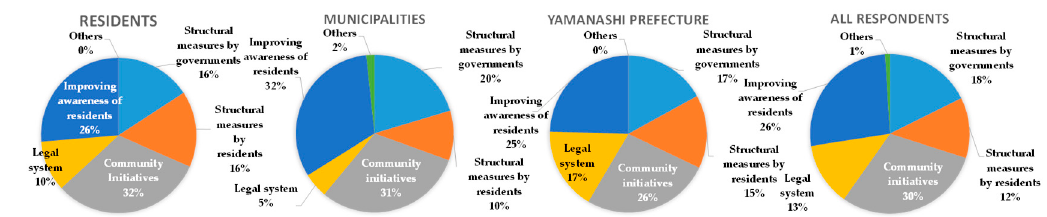
Figure 13. Answers to the question “What is necessary to make the Kofu Basin resilient to flood? (multiple answers allowed)”.